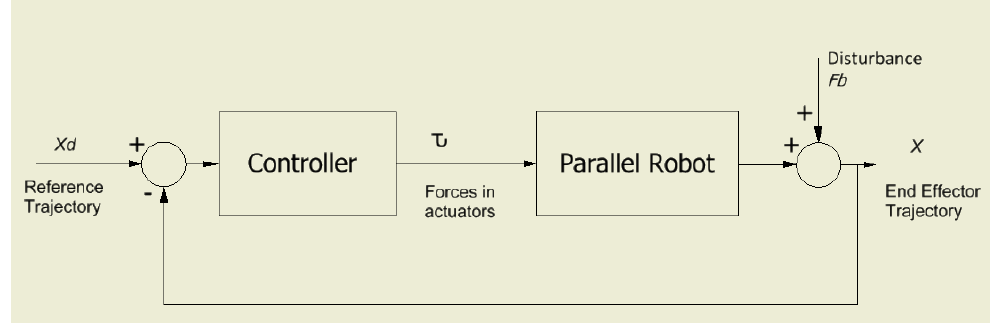
Figure 2. Topology of position control in task space.